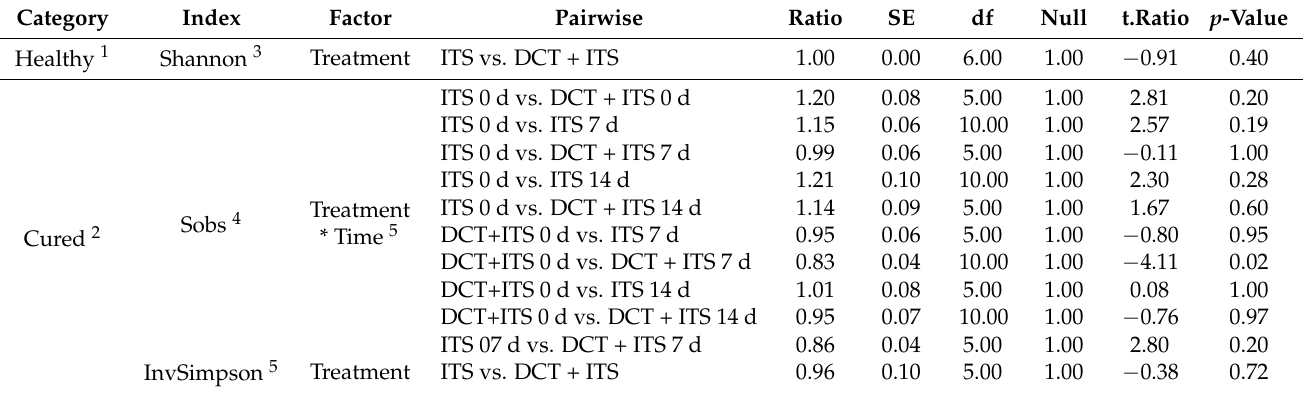
Table 4. Summary of pairwise comparisons (least-squares means) of the alpha diversity indices of milk bacterial